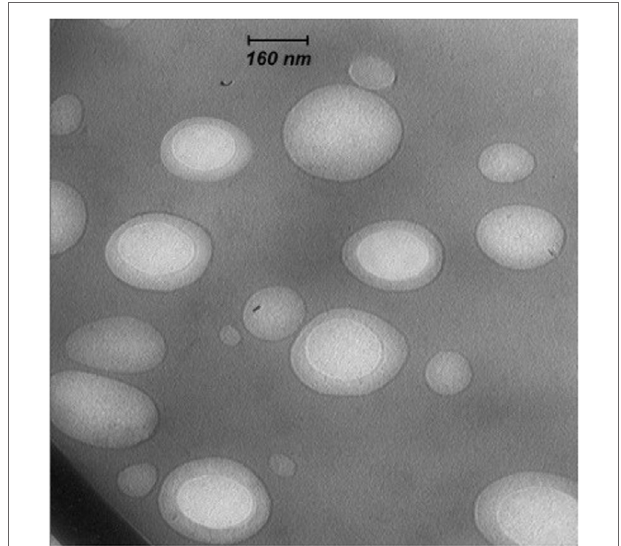
FigUre 2 | Transmission electron microscopy image of poly(lactic-co- glycolic) acid/polyethylenimine core–shell